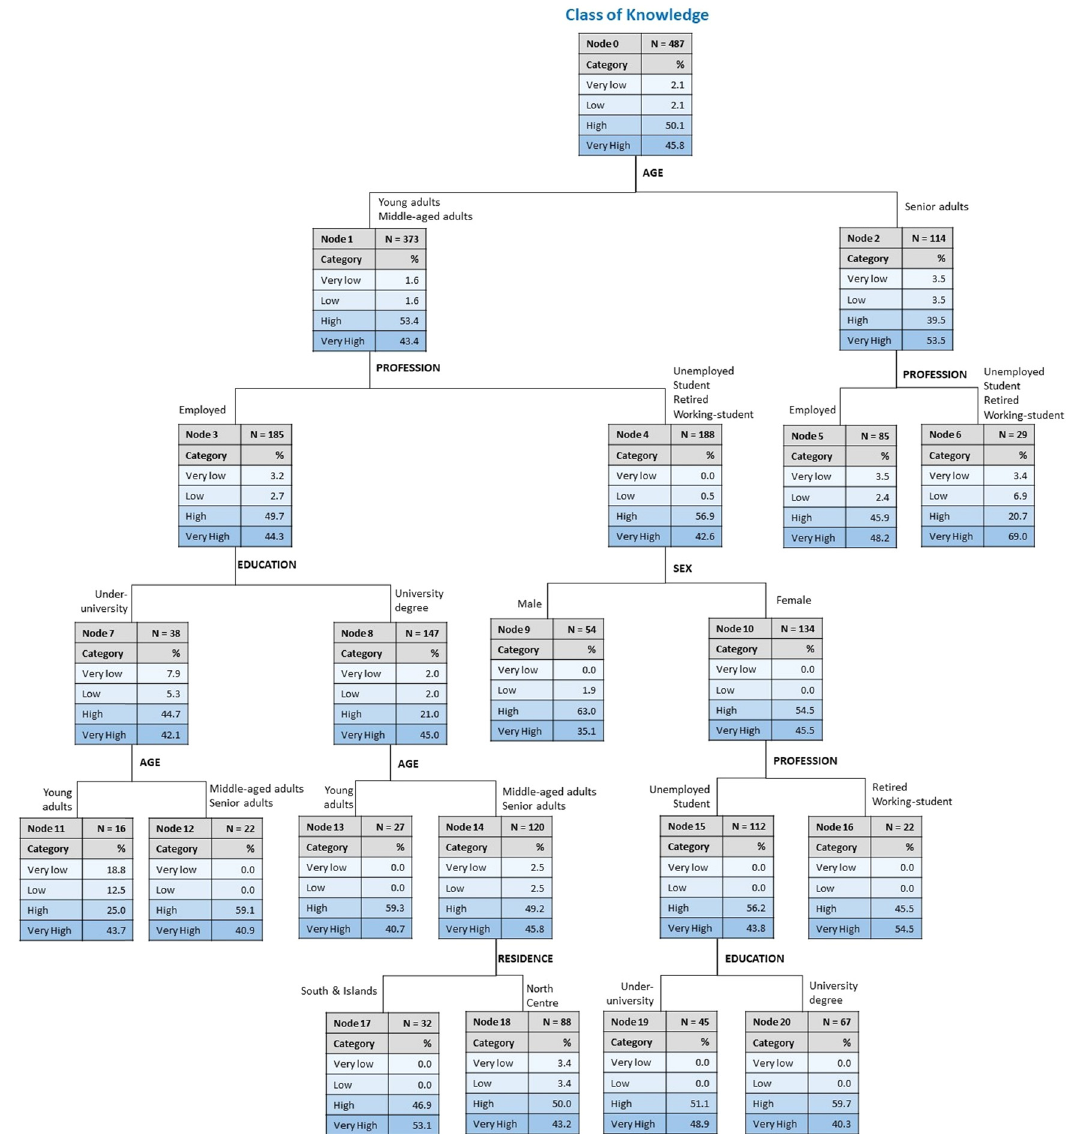
Figure 6: Tree classi fi cation for variable knowledge as a function of the sociodemographic